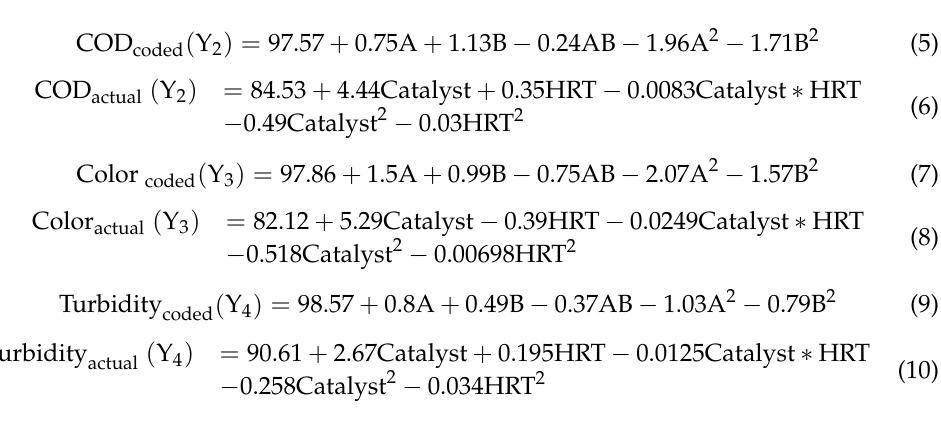
Table 3. Results of a modified RSM-BBD experiment and model predictions.